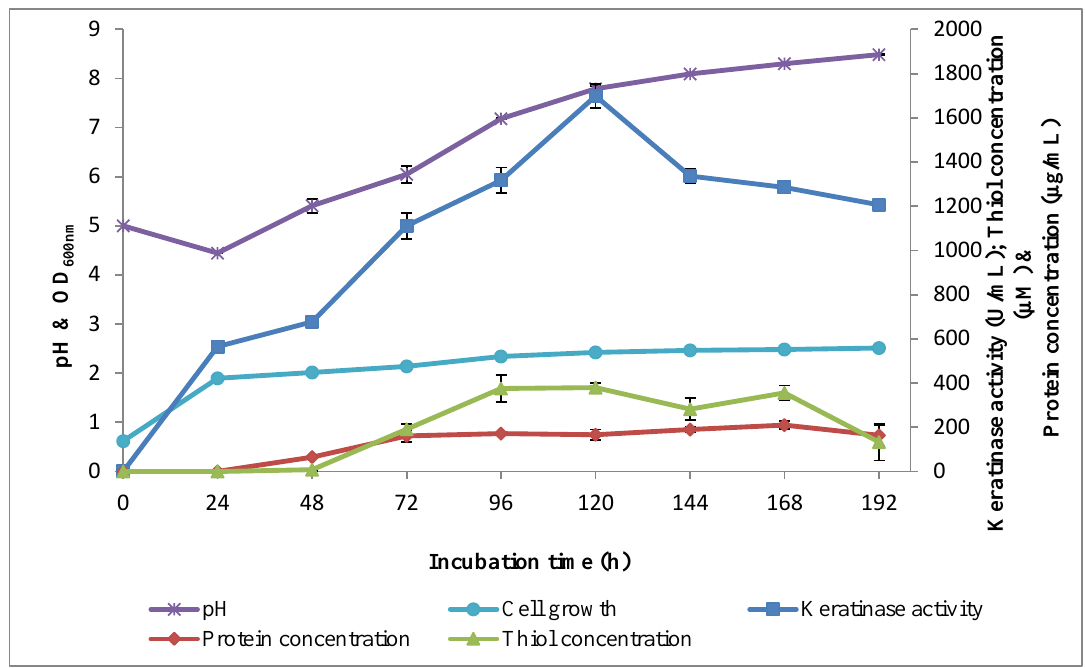
Figure 9. Time courses profile of keratinolytic activity by Bacillus sp. FPF-1 in an optimized fermentation medium at 25 °C and 150 rpm.